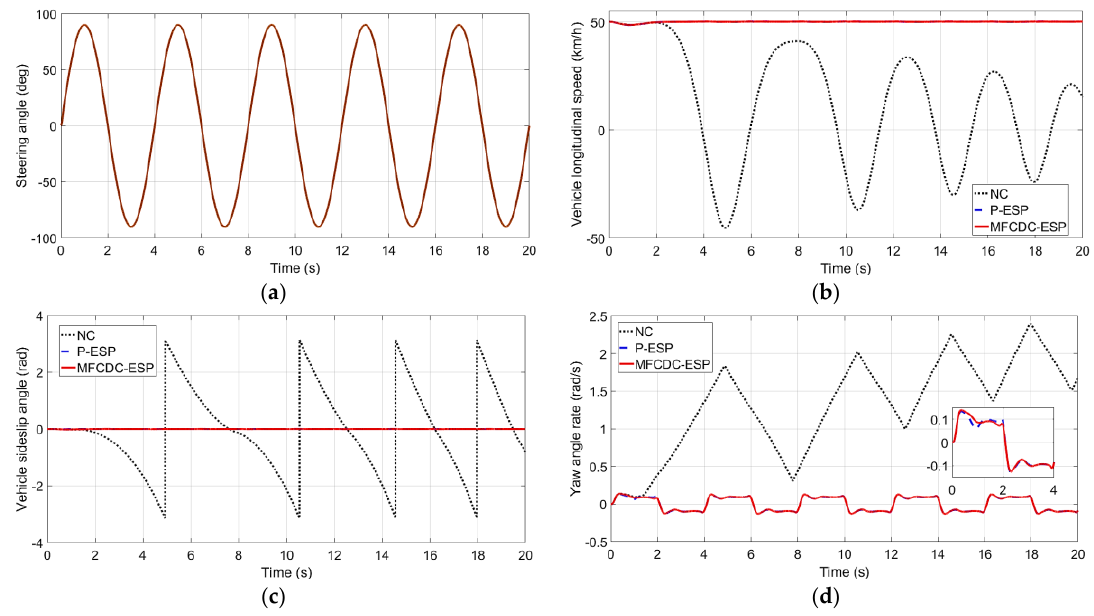
Figure 9. Steering angle, vehicle longitudinal speed, vehicle sideslip angle, and yaw angle rate of sine wave steer input test. The result of NC is expressed with a black dotted line; the result of P-ESP is expressed with a blue chain line; the result of MFCDC-ESP is expressed with a red solid line. ( a ) is the steer angle input of the simulation. ( b ), ( c ), and ( d ) are the comparisons of the vehicle longitudinal speed, vehicle sideslip angle, and yaw angle rate, respectively.